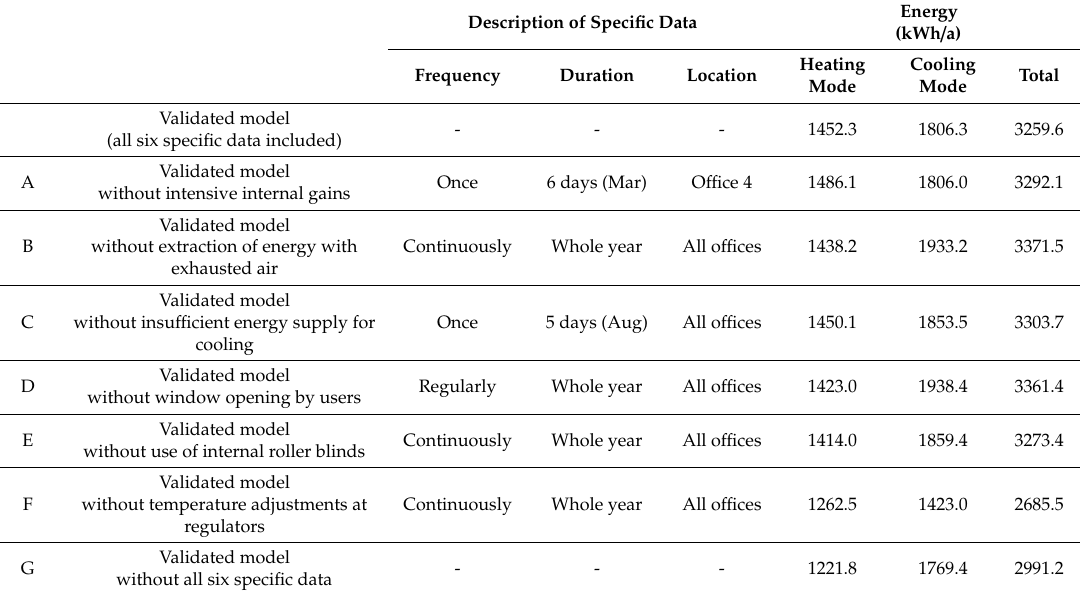
Table 1. Specific parameters in the analysis of the validated model and their influence on the simulation results for energy use at annual